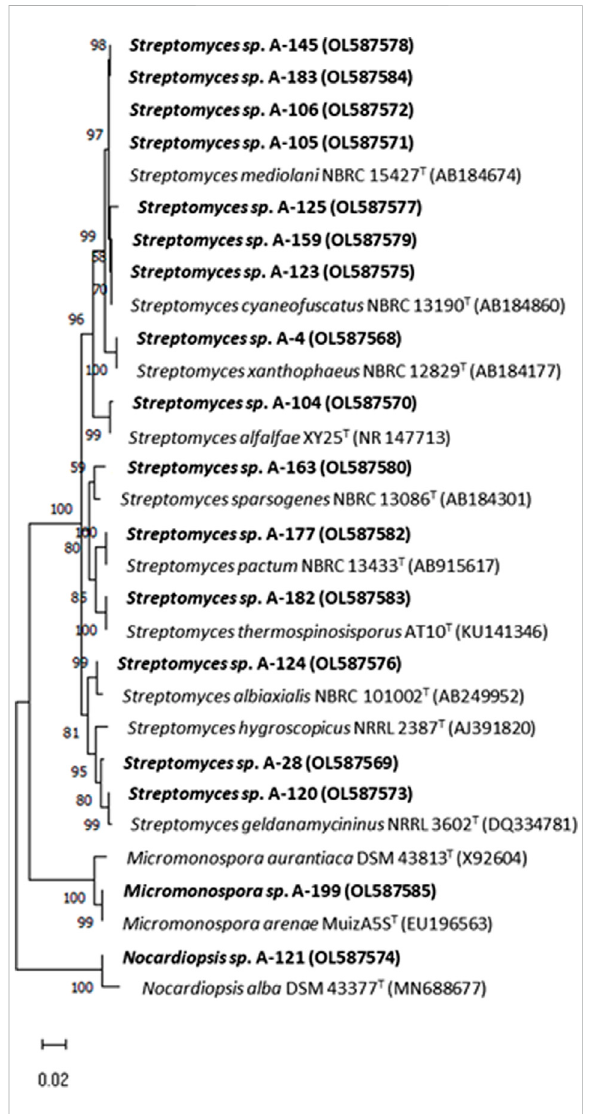
FIGURE 3 Neighbor-joining phylogenetic tree generated by distance matrix analysis of 16S rRNA gene sequences from atmospheric Actinobacteria, Streptomyces , Micromonospora and Nocardiopsis (highlighted) and their nearest phylogenetic relatives. The numbers on branch nodes indicate bootstrap values (1,000 resamplings; only values > 50% are shown). Bar represents 1% sequence